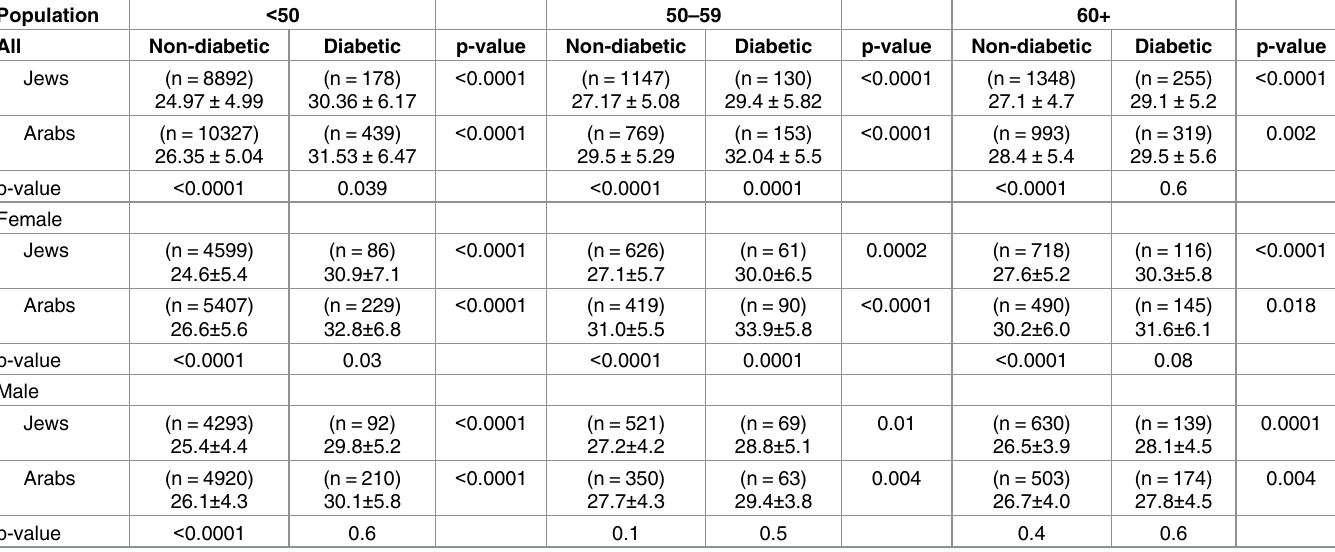
Table 4. BMI among patients with incident diabetes and healthy controls by ethnicity and age *